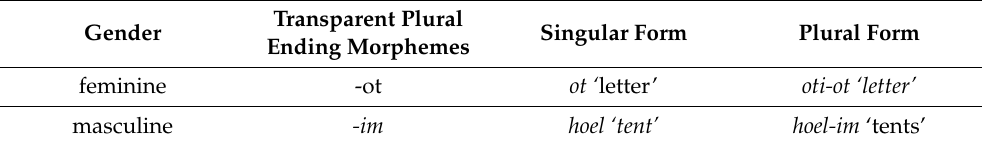
Table 5. Hebrew genderless plural noun